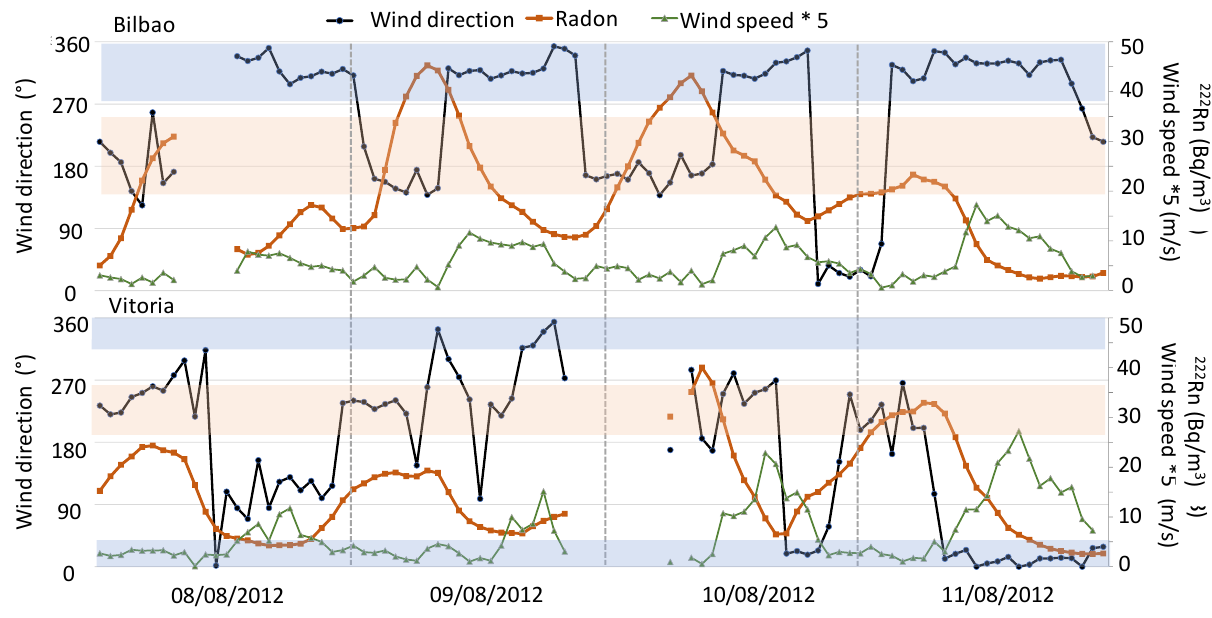
Figure 8. Hourly variation of wind direction and speed, and 222 Rn activity concentration between 7th and 11th August 2012 in Bilbao and Vitoria. Note differences in scales. Blue area represents wind direction of maritime flow, while brown area represents continental flows.